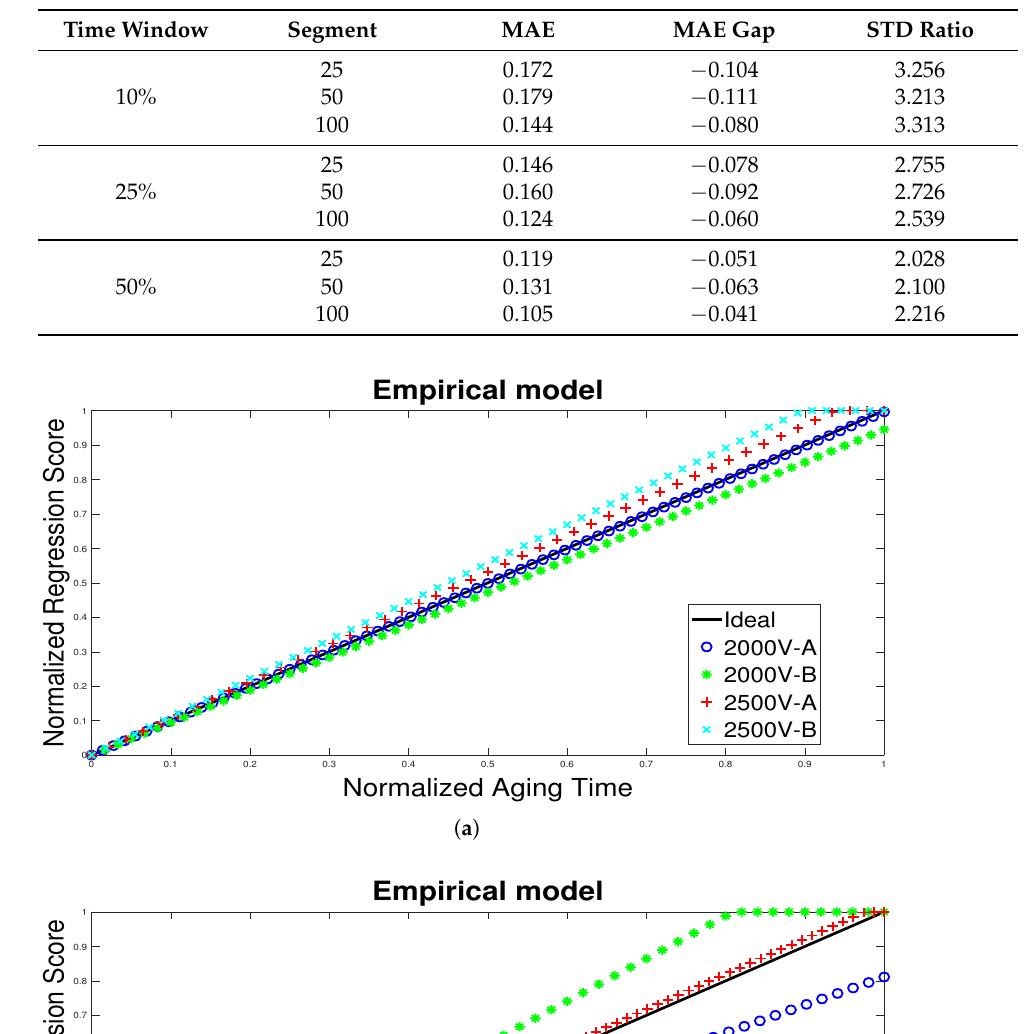
Table 5. Comparison Results between CNN and EM.